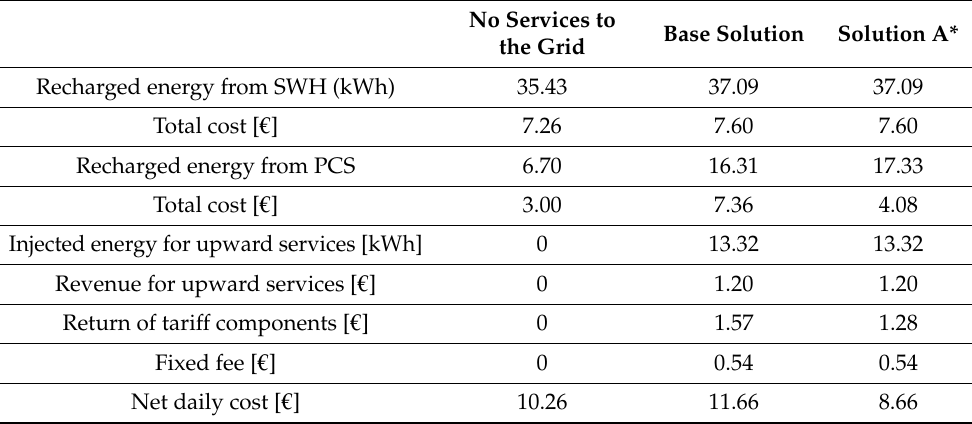
Table 26. Results for mobility pattern 3—UVAM (Scenario